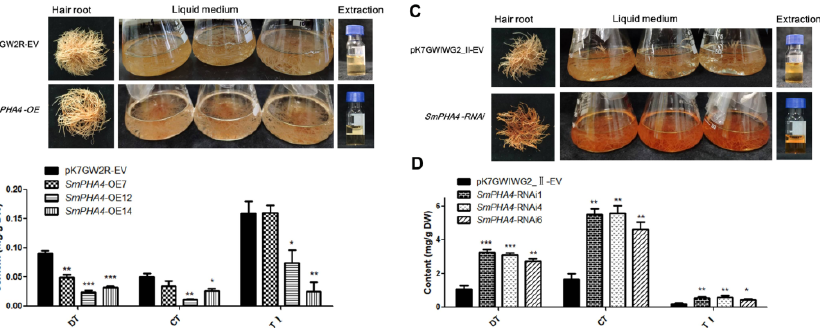
Figure 4. Analysis of the tanshinones in the SmPHA4-OE and SmPHA4-RNAi transgenic S. miltior-